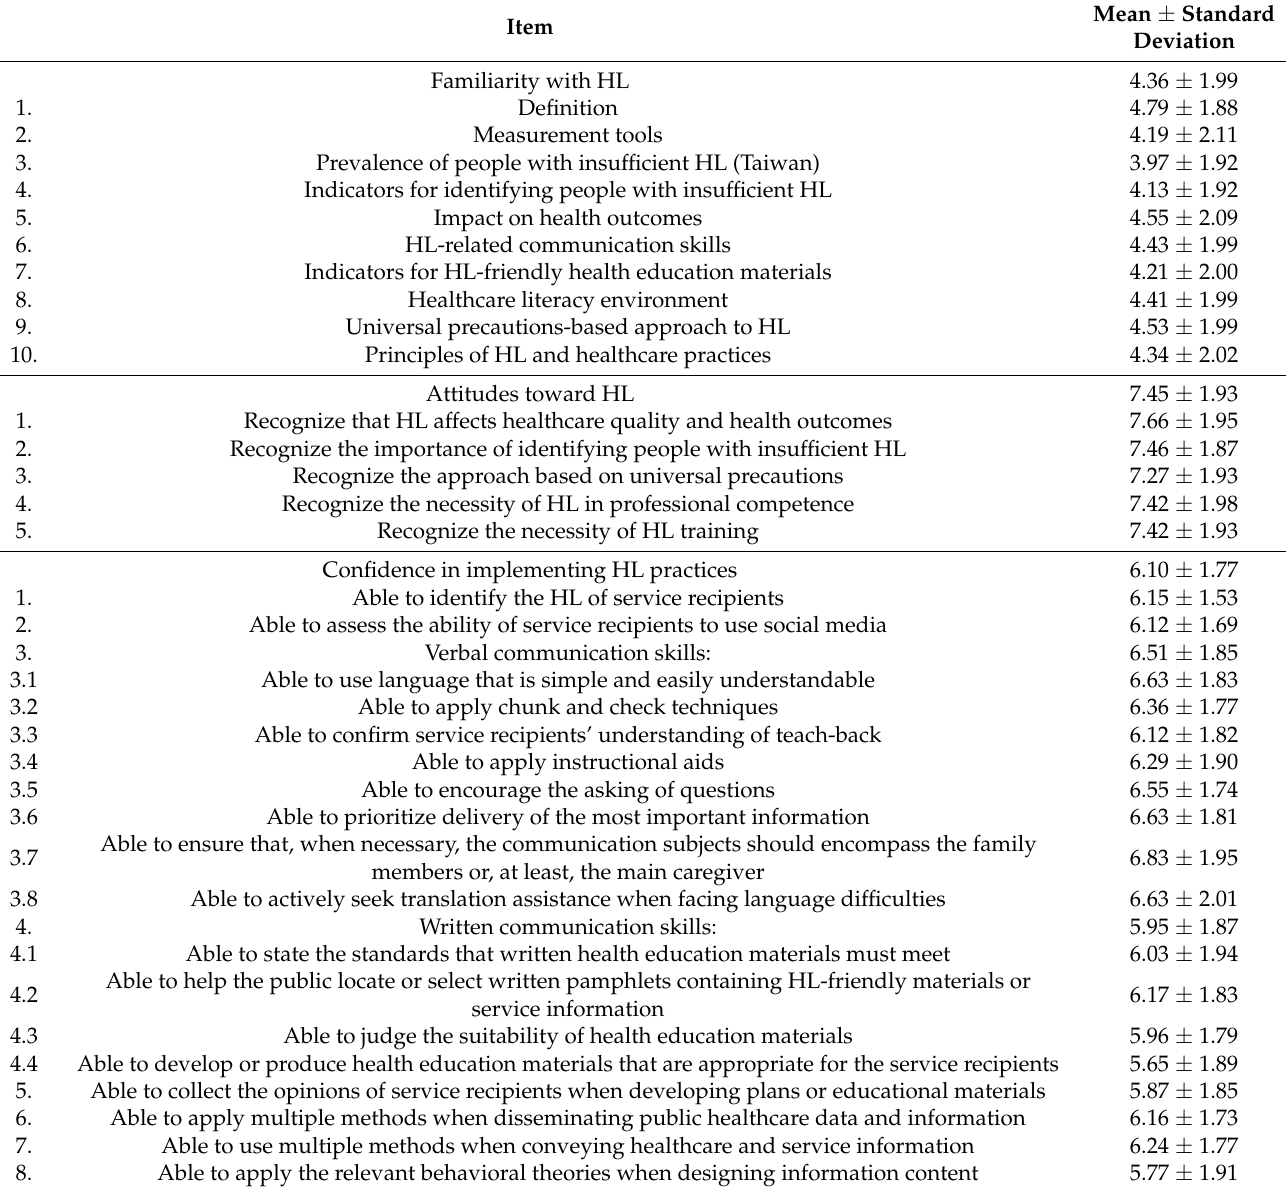
Table 2. CHPs’ familiarity with, attitudes toward, and confidence in implementing HL